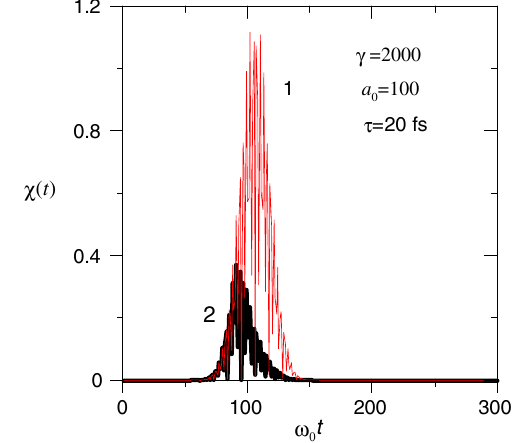
FIG. 3. Time evolution of the χ parameter for an electron γ ¼ 2000 without (1) (red curve) and with (2) (black curve) radiation damping in a 20 fs Gaussian pulse with a 0 ¼ 100 ; head-on collision.